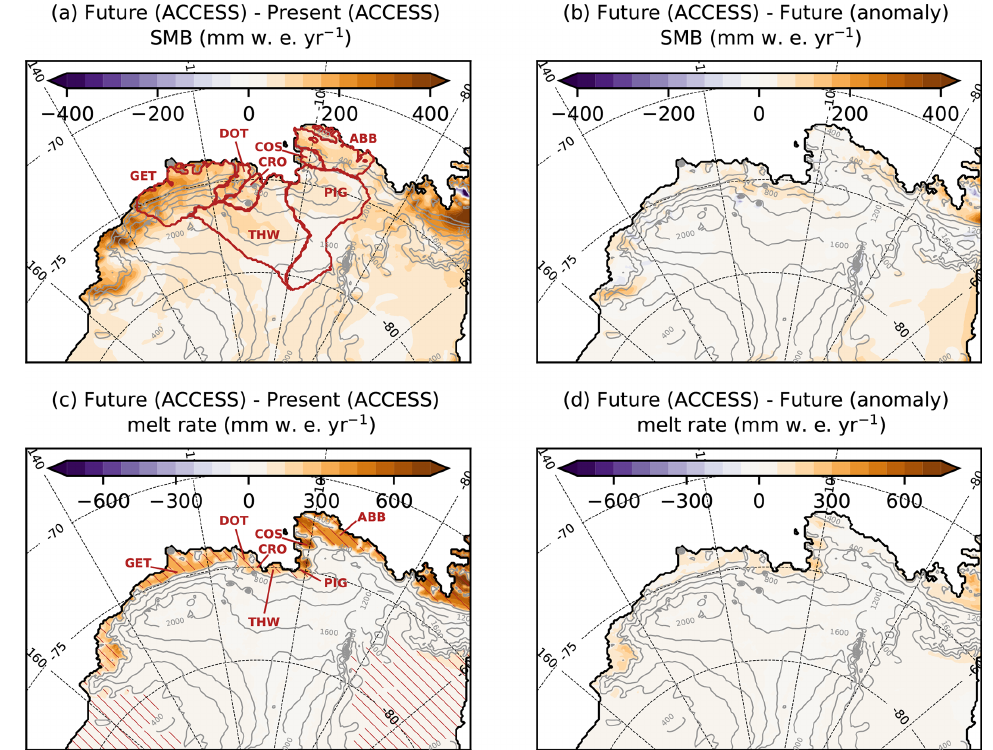
Figure 11. (a) SMB anomaly (2080–2100 minus 1989–2009) in ACCESS-1.3 directly downscaled by MAR (i.e. true changes). (b) Difference between the true future, from the direct downscaling of ACCESS-1.3, and the projected future, from the anomaly method. (c, d) Same as (a, b) but for melt rates instead of SMB. The dark red contours in panel (a) indicate individual glacial drainage basins: Getz (GET), Dotson (DOT), Crosson (CRO), Thwaites (THW), Pine Island Glacier (PIG), Cosgrove (COS), and Abbot (ABB). Red hatching in (c) indicates ice shelves. The ice-sheet topography is shown in grey (contours every 400m).